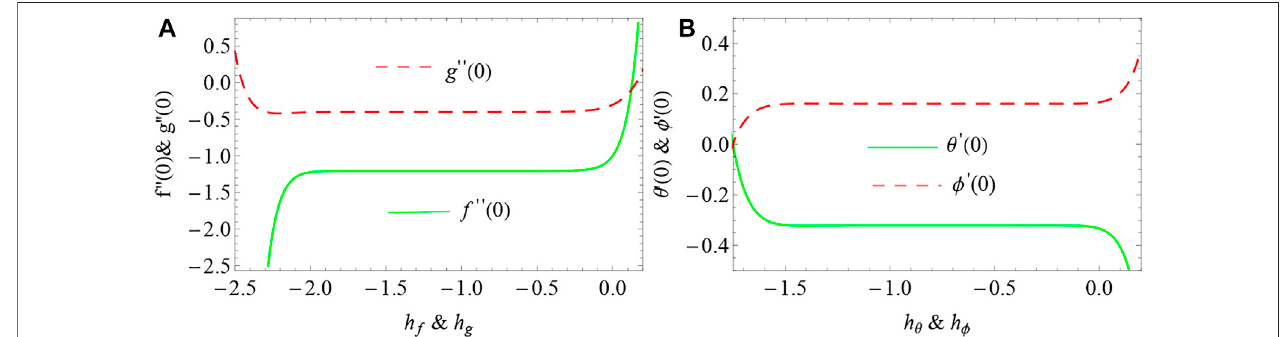
FIGURE 2 | h − graph of f ′′ (0) ̂ , g ′′ ̂ (0), θ ′ (0) ̂ , and ϕ ′ (0) ̂ .